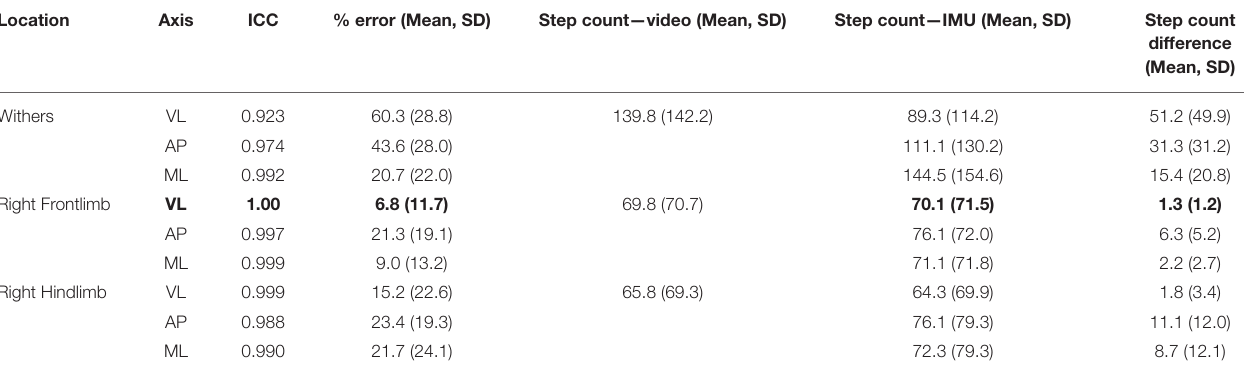
TABLE 2 | Results for the three accelerometer axes according to sensor location (all movements were combined to determine the best sensor location).